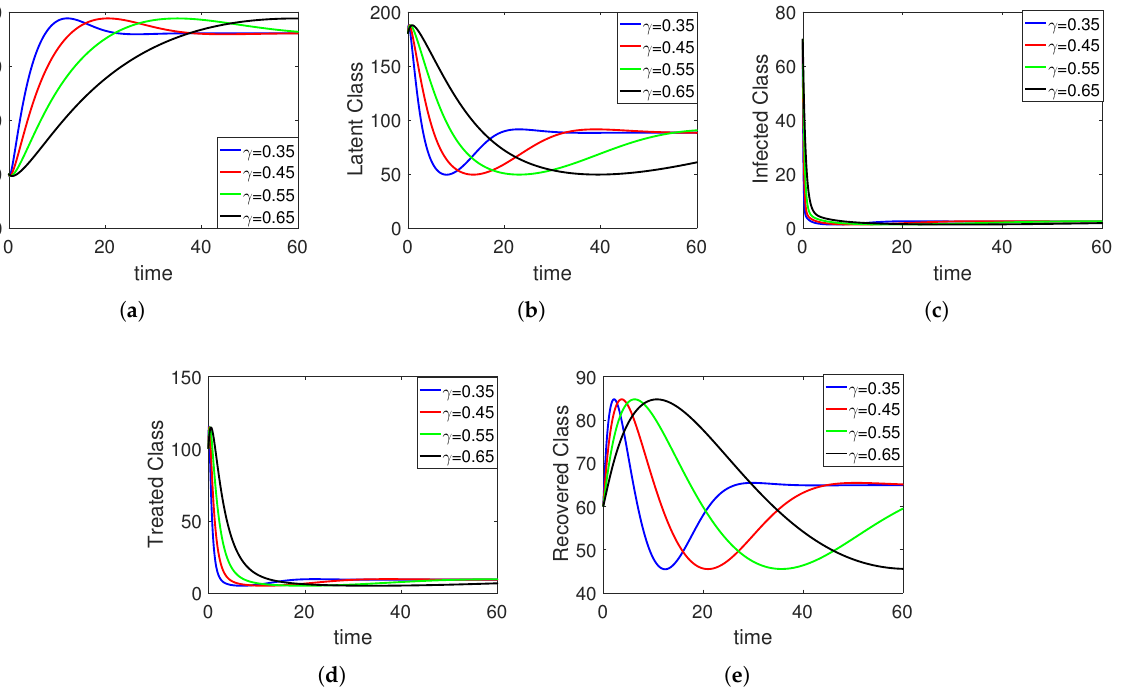
Figure 2. A graphic view of all five agents ( a – e ) of human society on different arbitrary orders γ = 0.35, 0.45, 0.55, 0.65 for initial data and time